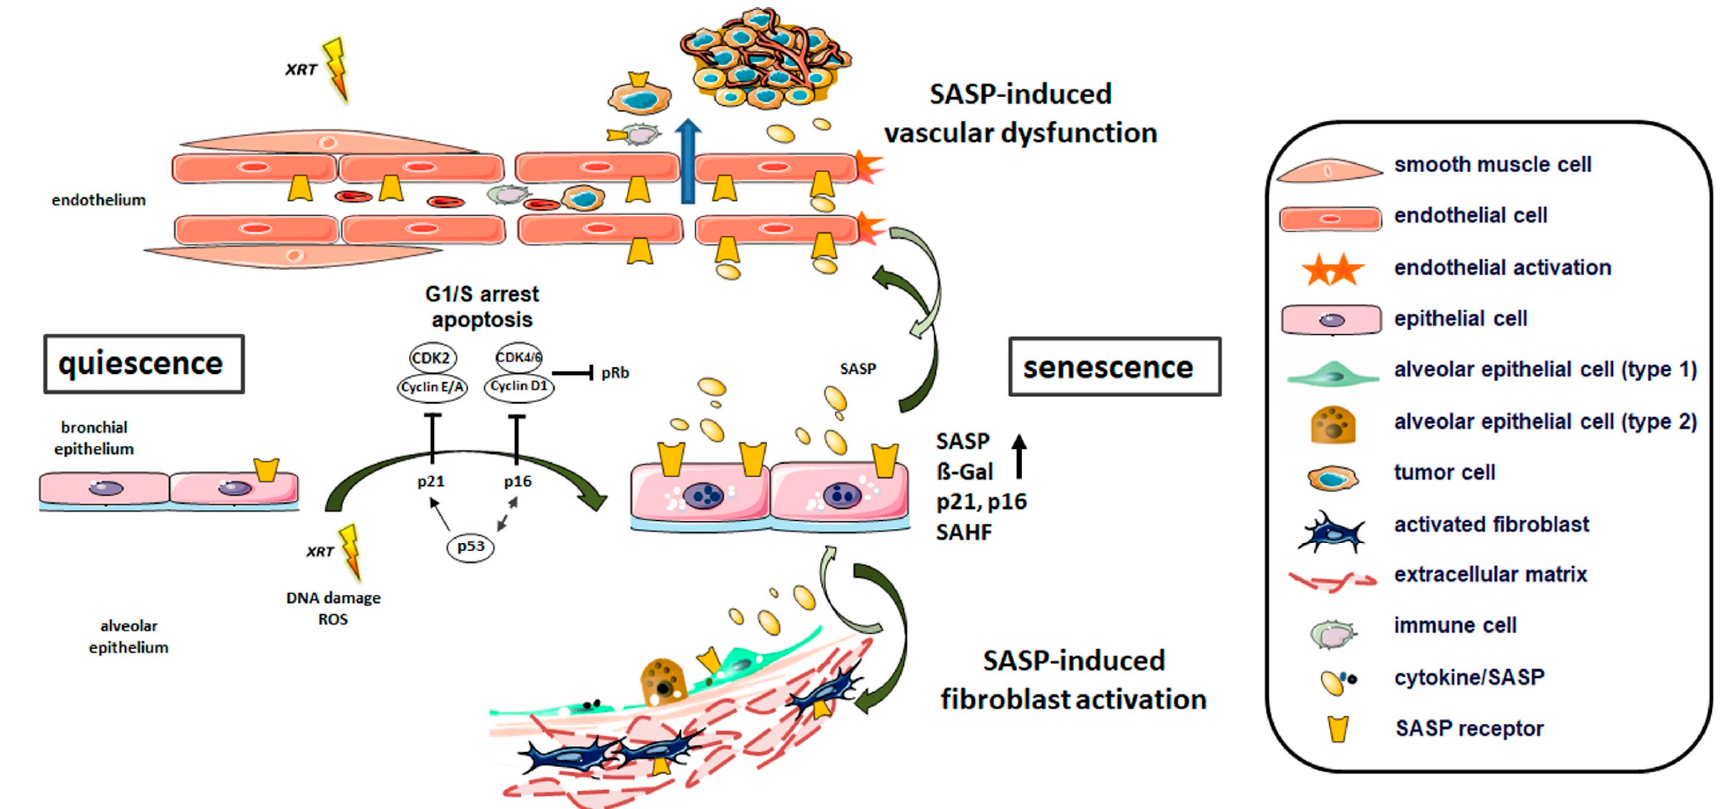
Figure 1. Cellular senescence orchestrating lung injury. Upon thoracic irradiations (XRT, as shown by the yellow flash), normal lung tissue reacts with complex and multiple interactions between resident cells: bronchial and alveolar epithelial cells, fibroblasts, and endothelial cells. Senescence of the respiratory epithelium is considered here as a central process for the initiation and progression of related lung diseases, particularly the development of pneumonitis and fibrosis (radiation- induced pneumopathy). Persistent or irreparable DNA damage following XRT in lung epithelial cells in turn can induce an irreversible cell cycle arrest that lead to apoptosis or to the establishment of cellular senescence. Mechanistically, senescence is induced and maintained by signaling cascades that activate p53/p21 and/or p16/Rb tumor suppressor pathways that inhibit epithelial cell cycle progression. Accordingly, increased p16 and p21 transcript levels can be observed. Senescent epithelial cells further bear characteristic morphological features: a larger and flat-like cell morphology, an increase in senescence-associated β -galactosidase (SA- β - gal) activity, and, in some cell types, a discernible change in chromatin organization known as senescence-associated heterochromatin foci (SAHF) that are marked by foci of histone H3 lysine 9 trimethylation. In addition, the proinflammatory and pro-oxidative senescence-associated secretory phenotype (SASP) of these cells, could reinforce the senescence arrest, alter the microenvironment and thus impair the function of neighboring cells in a paracrine manner. Radiation-induced